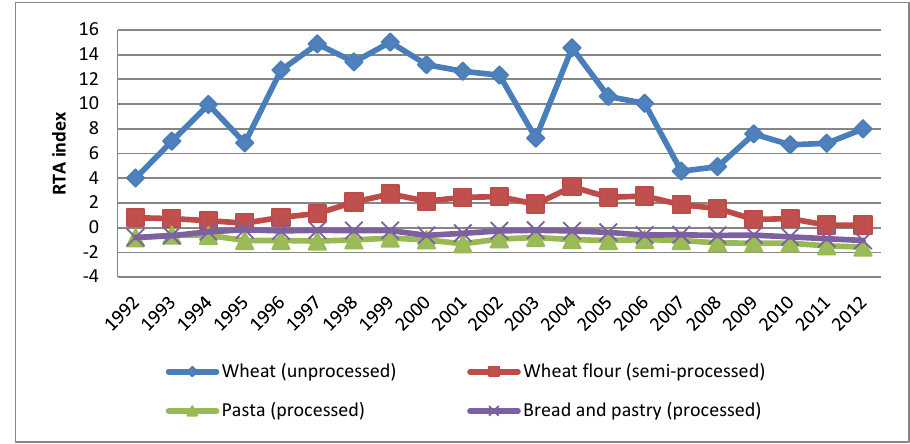
FIGURE A3: Trends in RTA index values for unprocessed, semi-processed and processed wheat in